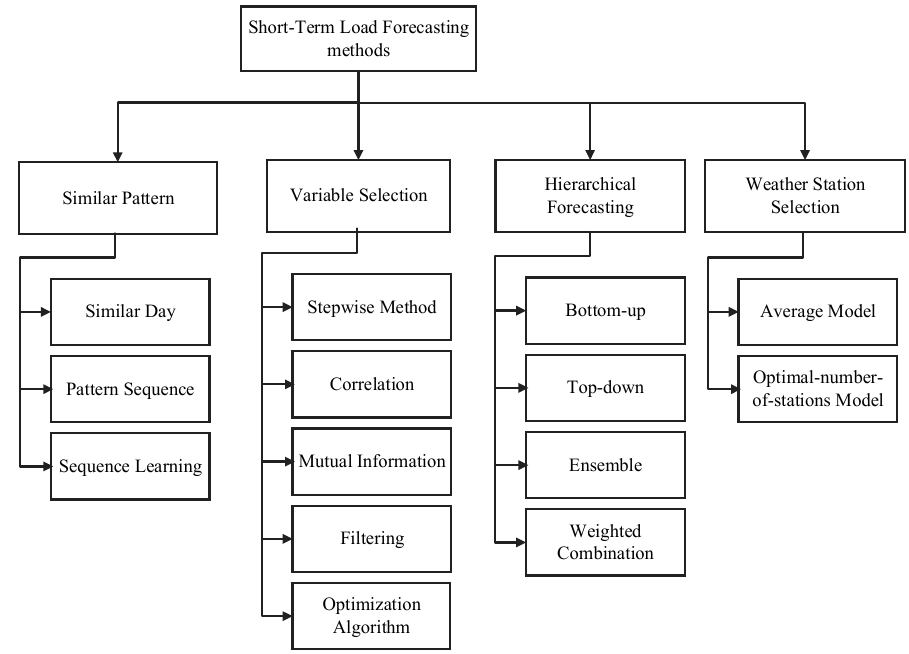
Figure 1. Tree diagram of the STLF methods .